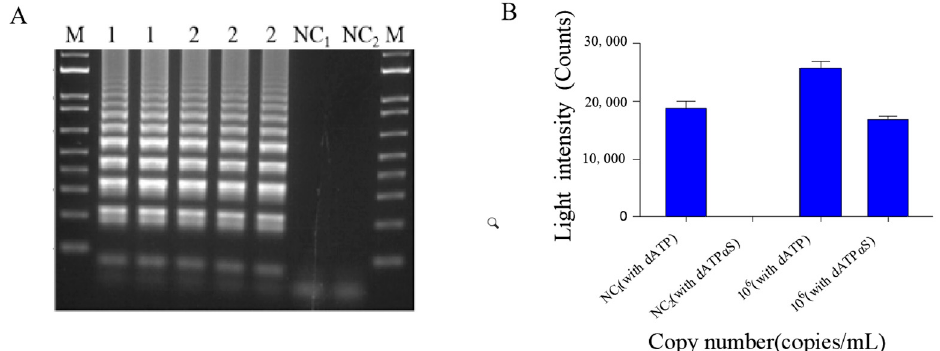
Figure 2. ( A ) Agarose gel electrophoresis of RT-LAMP products. Lanes NC 1 , 1, 2, and M correspond to the negative control, 10 6 copies/ µ L of the purified template pseudoviral plasmid reference RNA (with dATP), 10 6 copies/ µ L of the purified template pseudoviral plasmid reference RNA (with dATP α S) and the marker (DL2000), respectively. ( B ) Light intensity (counts) of the purified template pseudoviral plasmid reference RNA (with dATP), 10 6 copies/ μ L of the purified template pseudoviral plasmid reference RNA (with dATP α S) and the negative control of dATP and dATP α S.